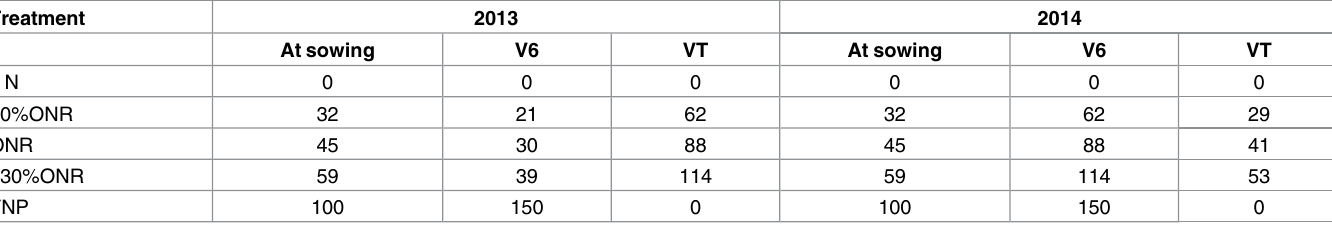
Table 1. N fertilizer application rate (kg N ha − 1 ) of different N treatments applied at sowing, six-leaf (V6) and silking (VT) stages during the two-year study. The N treatments includeda no N control (0 N), the optimal N rate based on in-seasonroot zone N management (ONR), 70% ONR, 130%ONR, and farmers’ standard N practice